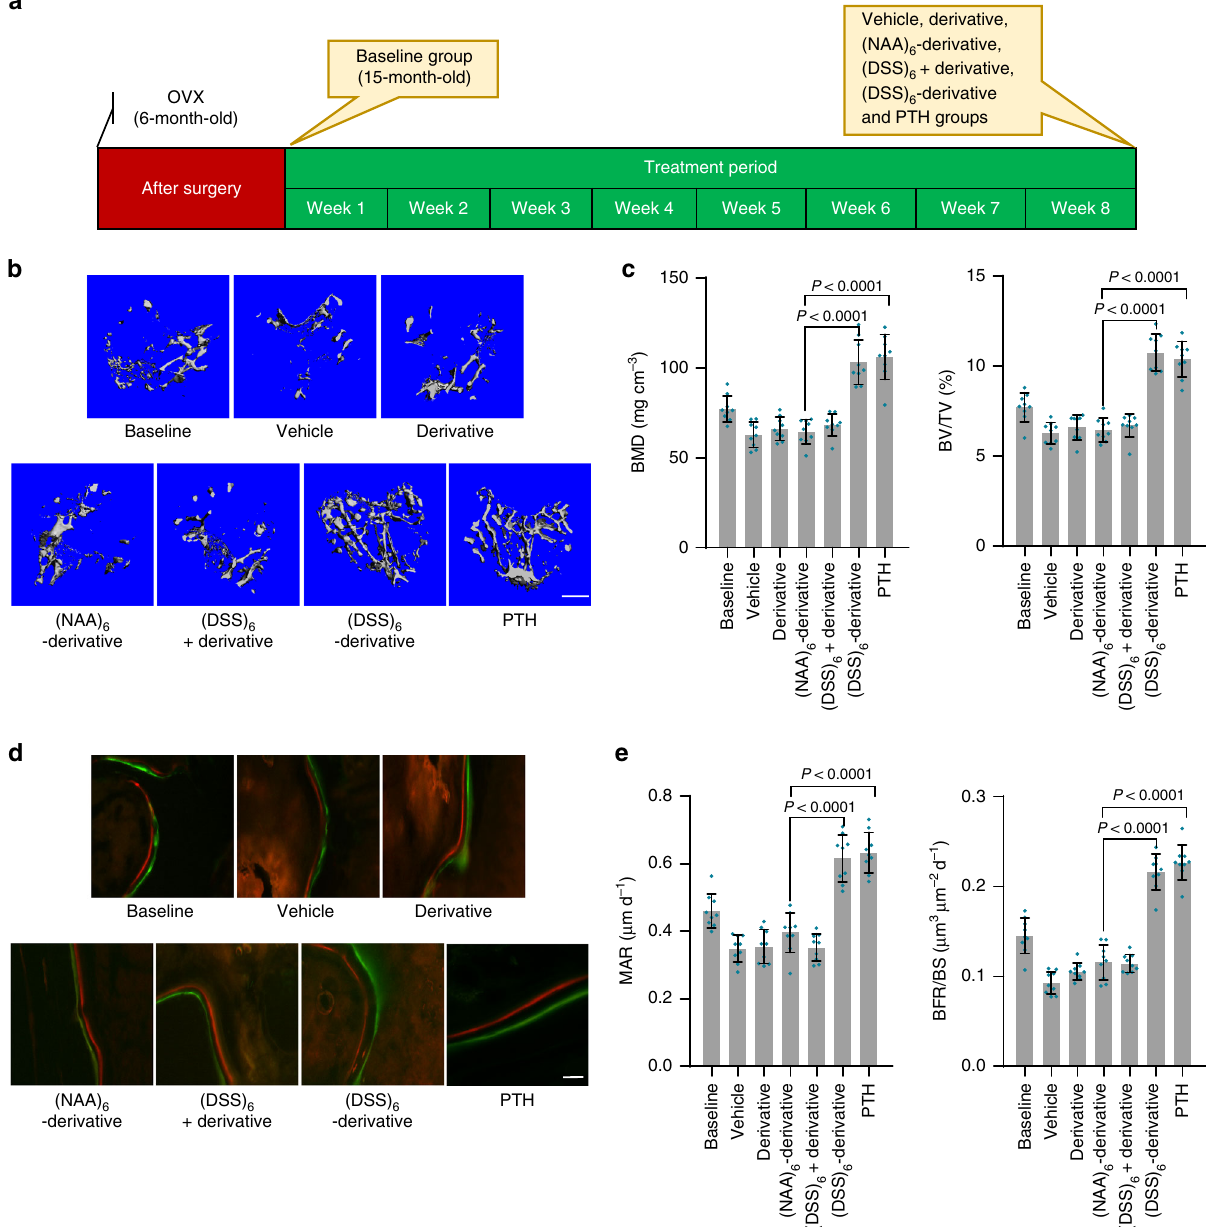
Fig. 6 Systemic bone anabolic action of the chalcone derivative formulations in BMP-2 n /Smurf1 e mice. a A schematic diagram illustrating the experimental design. 6-month-old mice were OVX and left untreated for 9 months (15-month-old) to induce osteoporosis. The mice received intravenous administration of different chalcone derivative formulations at a dose of 10.0 μ mol kg – 1 , with an injection interval of once every three days, or daily subcutaneous injection of recombinant human parathyroid hormone (PTH, amino acids 1 – 34) at a dose of 40.0 μ g kg – 1 . b Representative images showing three-dimensional trabecular architecture by microCT reconstruction at the proximal tibia. Scale bars, 500 μ m. c microCT measurements for BMD and BV/TV at the proximal tibia. d Representative images showing bone formation at the proximal tibia assessed by xylenol (red) and calcein (green) labeling. Scale bar, 10 µ m. e Analysis of dynamic bone histomorphometric parameters (MAR and BFR/BS) at the proximal tibia. n = 9 per group. Data are mean ± s.d. followed by one-way ANOVA with a post-hoc